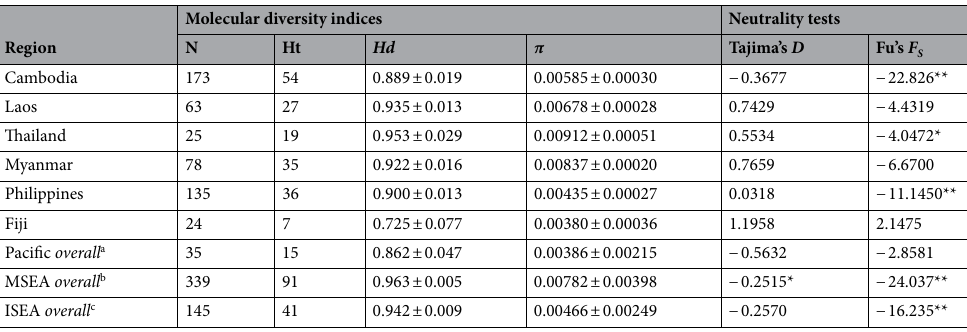
Table 1. Genetic diversity indices of Southeast Asian and Pacific chicken populations estimated using complete mtDNA D-loop sequences. a Included published sequences of Pacific chickens ( n = 11). b Combined sequences representing MSEA (Cambodia, Laos, Thailand, and Myanmar chickens). c Combined sequences representing ISEA (Philippine chickens and database sequences of Indonesian chickens; n = 10). N number of sequences, Ht number of haplotypes, Hd haplotype (gene) diversity, π nucleotide diversity. * p < 0.05 ; ** p < 0.01